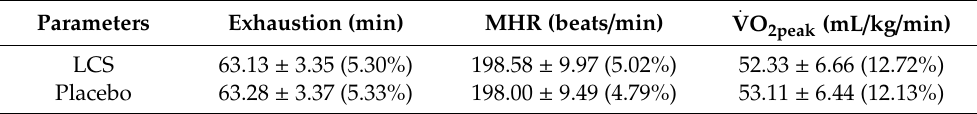
Table 4. Changes in aerobic capacity after exhaustive endurance